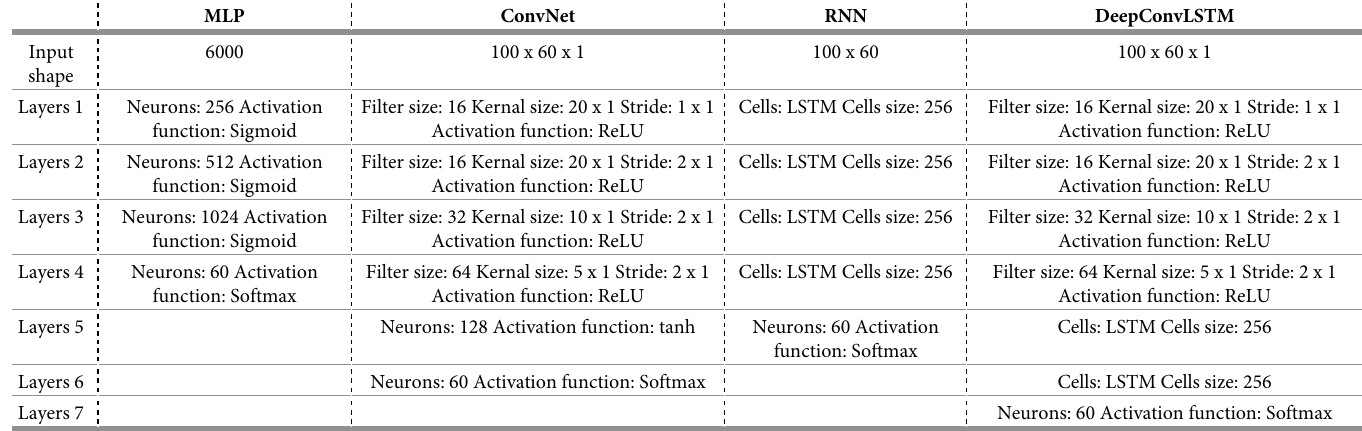
Table 2. Detail of the hyperparameters retained for Multi-layer Perceptron (MLP), convolutional neural network (ConvNet), recurrent neural network (RNN) and DeepConvLSTM. MLP ConvNet RNN